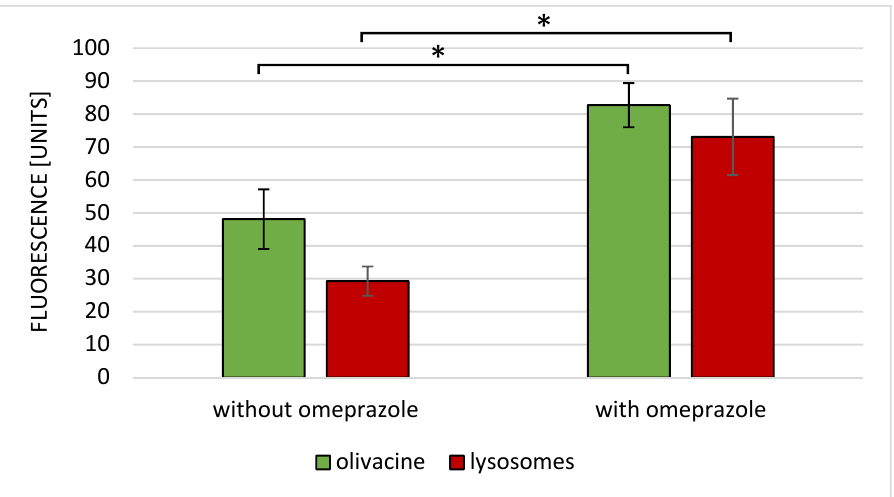
Figure 7. Mean fluorescence of olivacine and lysosomal absorbance after administration of olivacine with or without omeprazole. * p < 0.05.